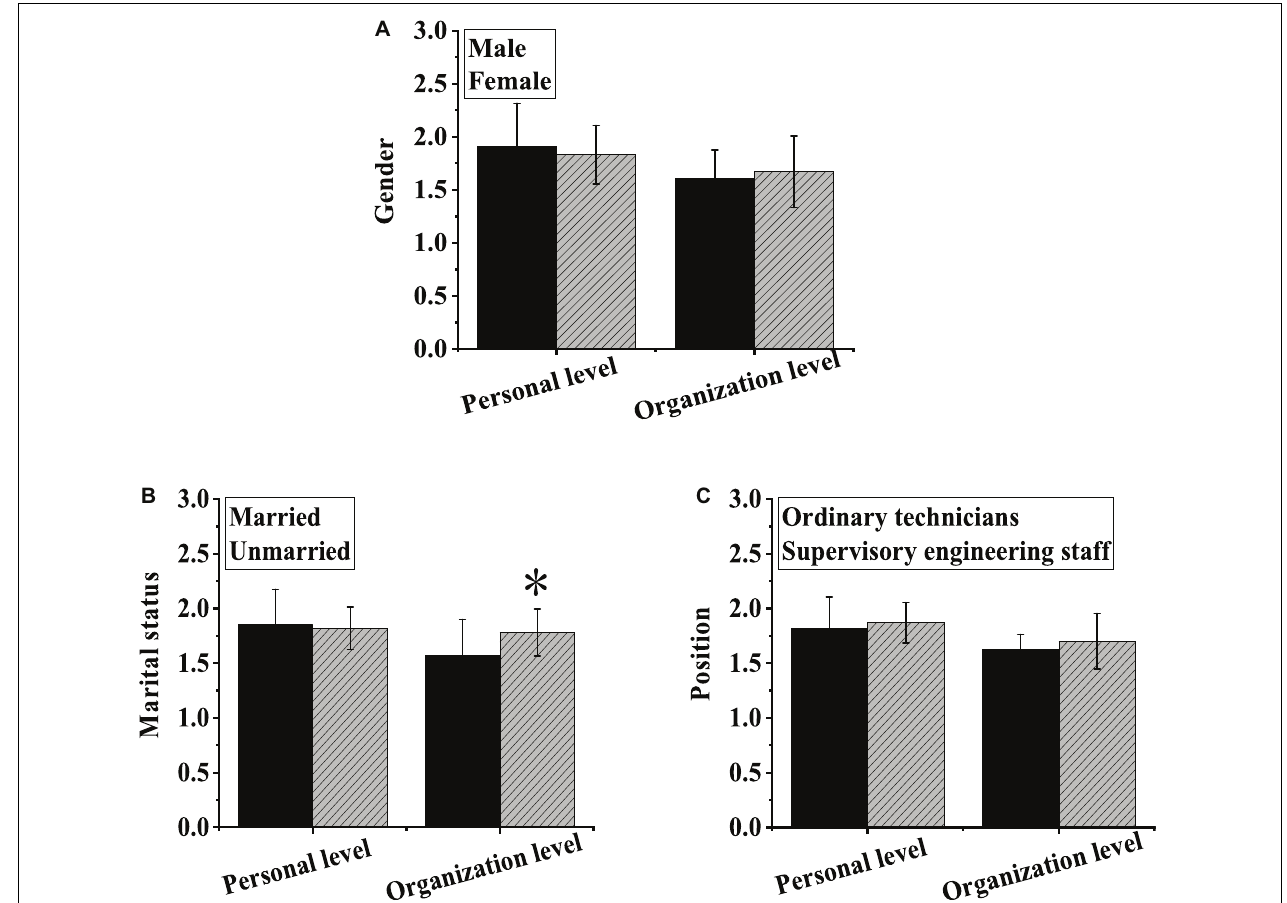
FIGURE 3 | Differences in stress-coping strategies between subjects of different genders (A) , marriage status (B) , and work positions (C) . ∗ Indicated that compared with married employees, the difference was notable ( P < 0.05).